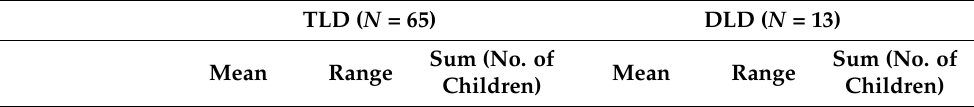
Table 6. Means, ranges, and frequencies of non-targeted CS for constituents within the temporal phrase in English and Hebrew, for children with TLD and